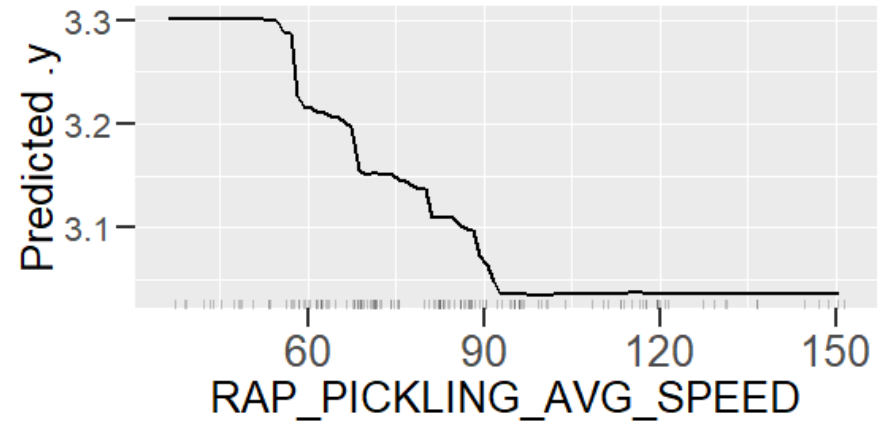
Figure 9. PDP of the speed of the RAP process.